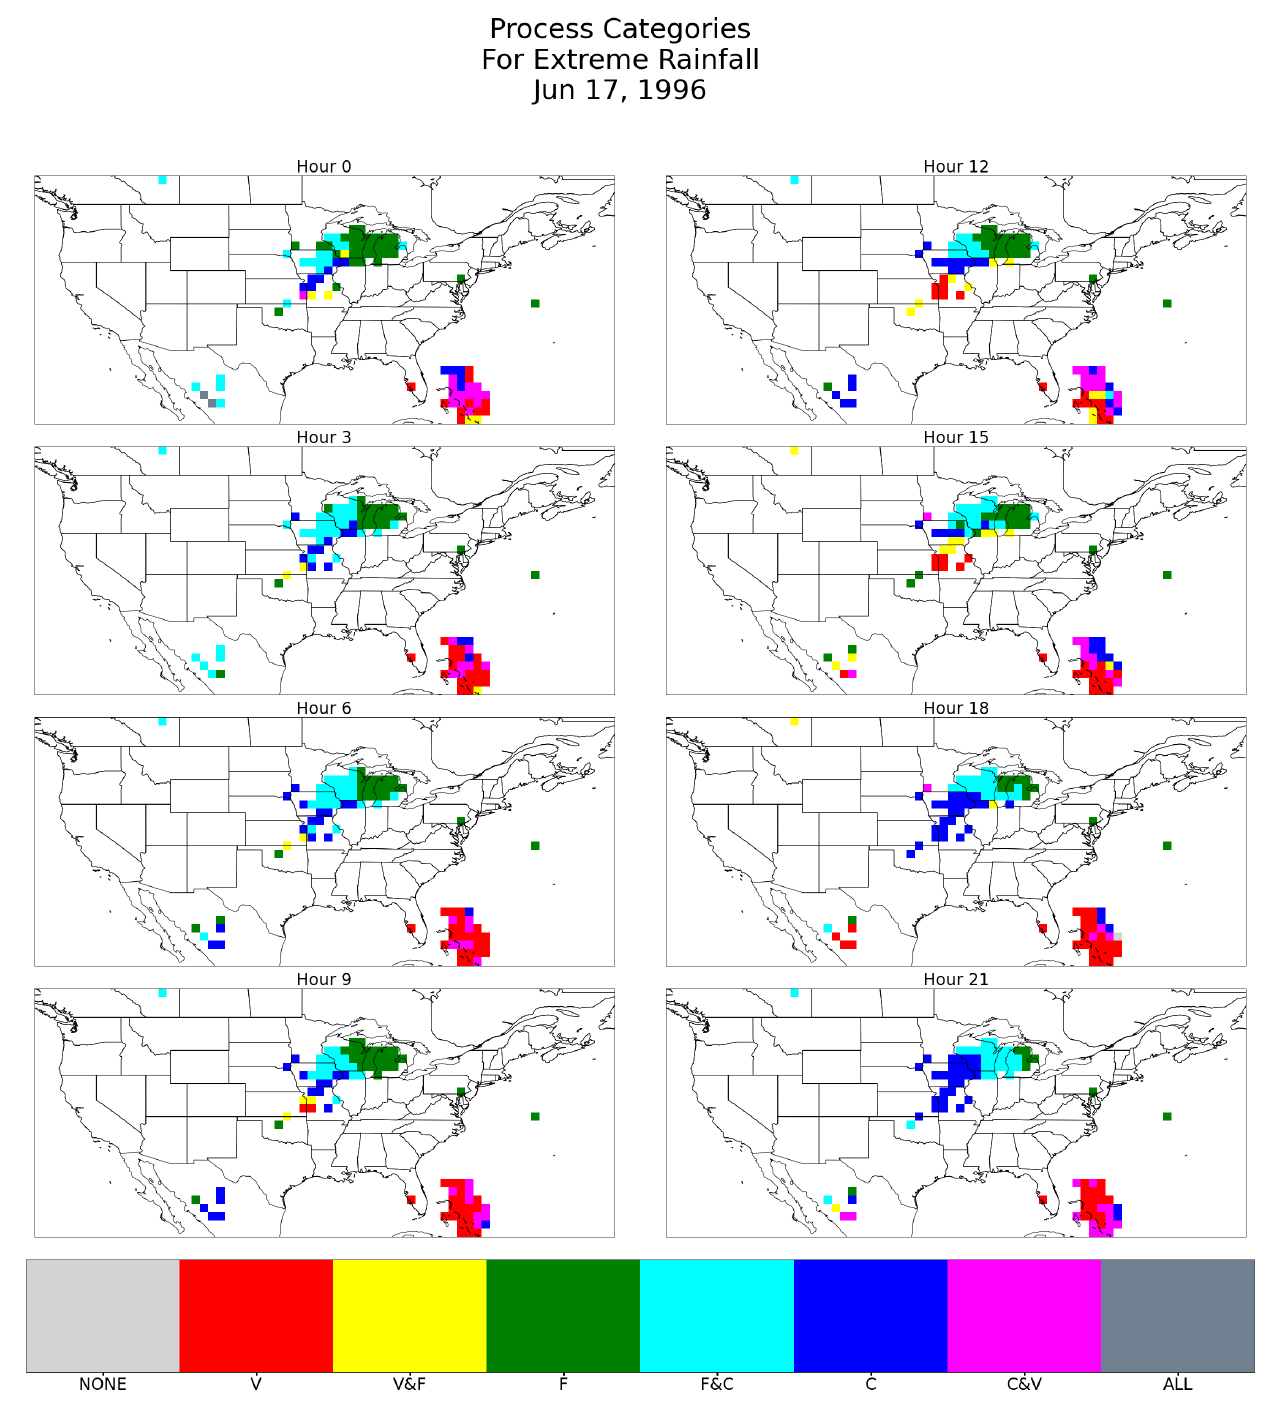
Figure 11. Plot of the process category for each grid point with precipitation > 12.5 mm during the day of 17 June 1996. The categories are labeled as follows: V—Vorticity, F—Frontal, C—Convection. The area of interest is the connected area of colored dots surrounding Wisconsin, labeled an extratropical cyclone by Kunkel [1]. All times are